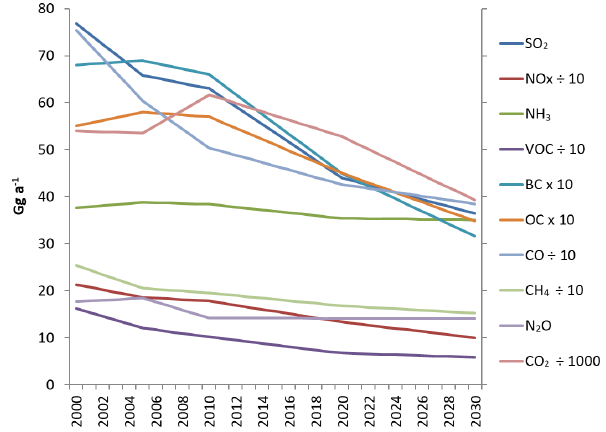
Figure 1. Finnish emissions (Gga − 1 ) of air pollutants and green- house gases in the period 2000 to 2030 in the baseline scenario. Emissions by sector for 2000, 2010 and 2030 can be found in Ta- ble S1 of the Supplement.